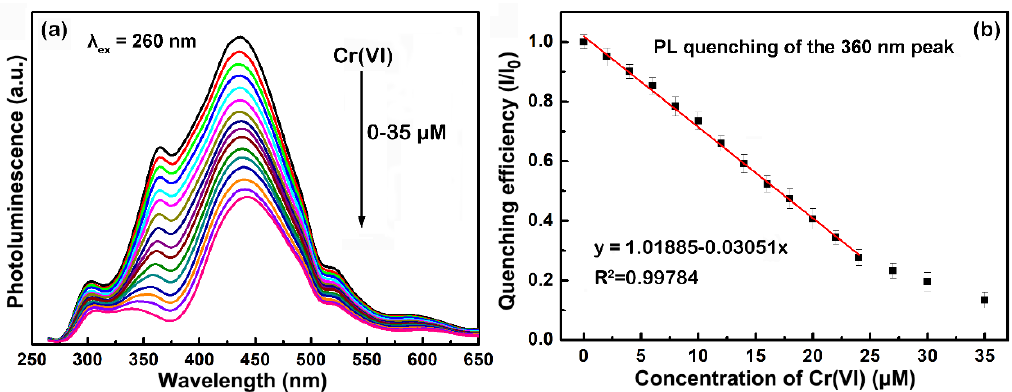
Figure 6. ( a ) Fluorescent quenching of the CNDs by increasing amounts of Cr(VI). ( b ) Relationship between the quenching efficiency (I/I 0 ) and the concentration of Cr(VI). Table 1. Comparison of the detection limit of the recently reported CNDs probes for Cr(VI).